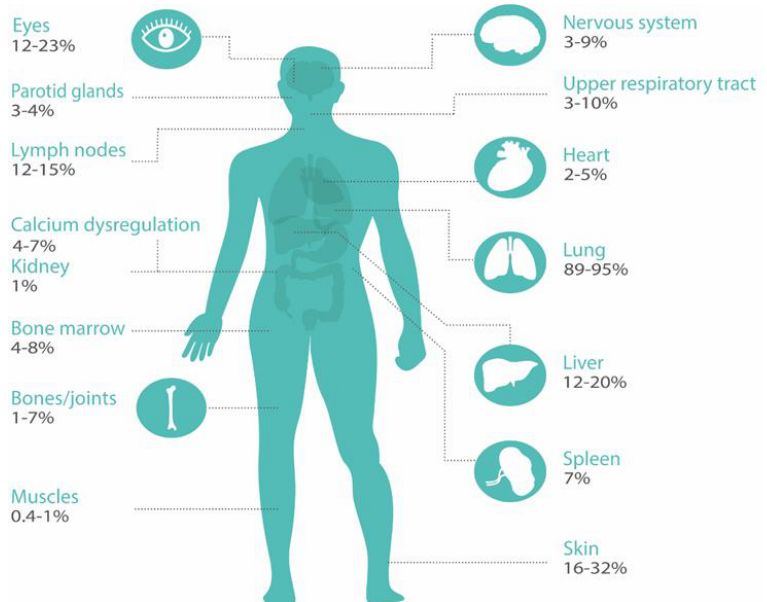
Figure 1. Organ involvement in sarcoidosis. Organ involvement is classified according to the ACCESS organ assessment instrument [8]. Prevalence data are used from references [1,9].